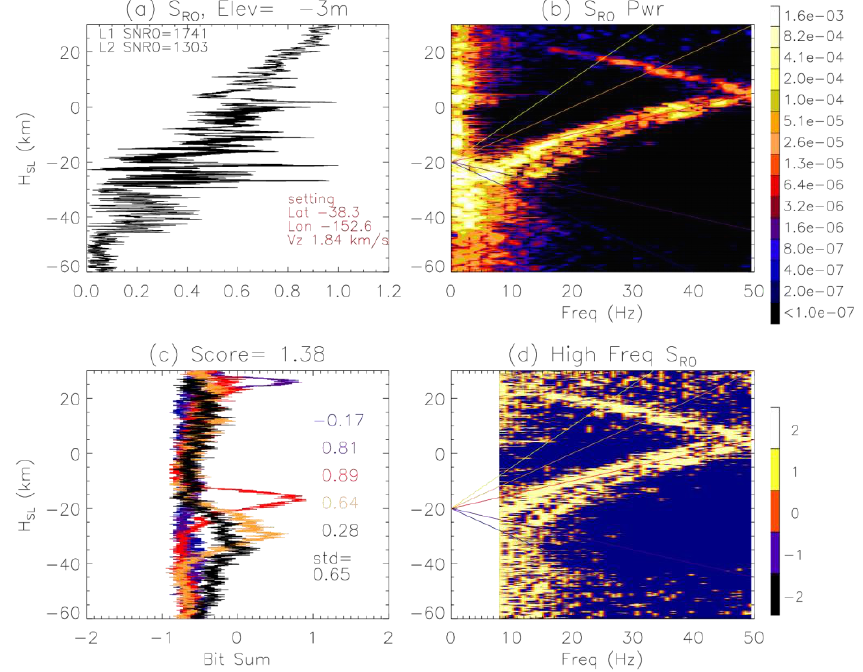
Figure A9 . Detection and score methods for reflection features in the RO SNR at H SL between −60 and 30 km.